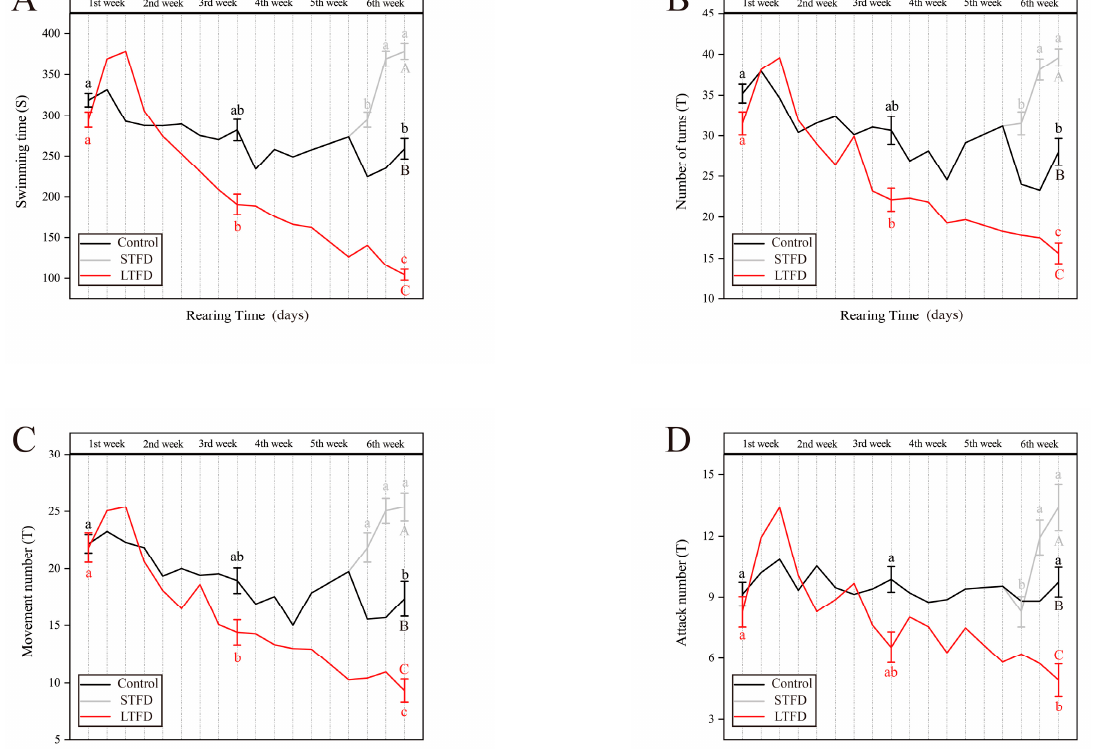
Figure 4. Trends in the different kinds of capacity for the action of black rockfish ( Sebastes schlegelii Hilgendorf, 1880) during rearing. The horizontal axes of the four figures represent rearing time (from the first week to the end of the sixth week, measured three times a week), and the vertical axes are, respectively, swimming time (ST, A ), number of turns (NT, B ), movement number (MN, C ), and attack number (AN, D ). In each figure, the black line represents the control group, the light gray line represents the STFD group, and the red line represents the LTFD group. Different colors of lowercase letters represent significant differences within each treatment group (control group: black; STFD group: light gray; and LTFD group: red. One day was selected for the early, middle, and late stages for each treatment group). Different capital letters indicate significant differences between the three treatment groups. Data are presented as means ± S.E.